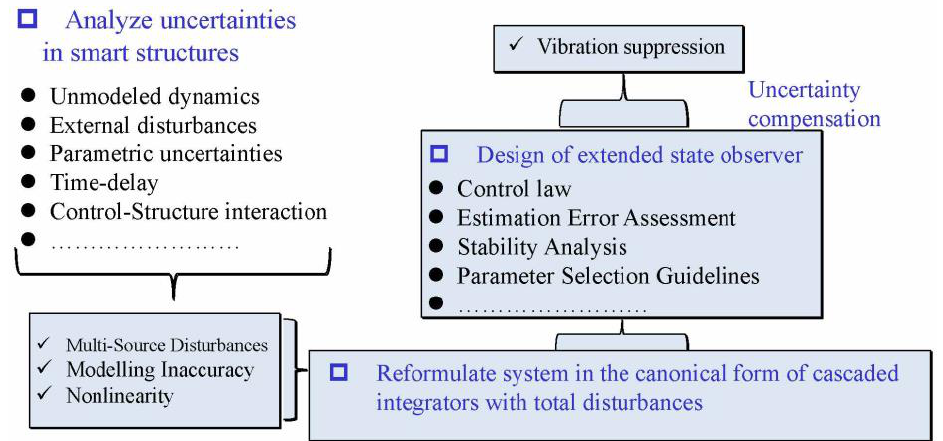
Figure 3. Design flow diagram of ADRC for smart structure.